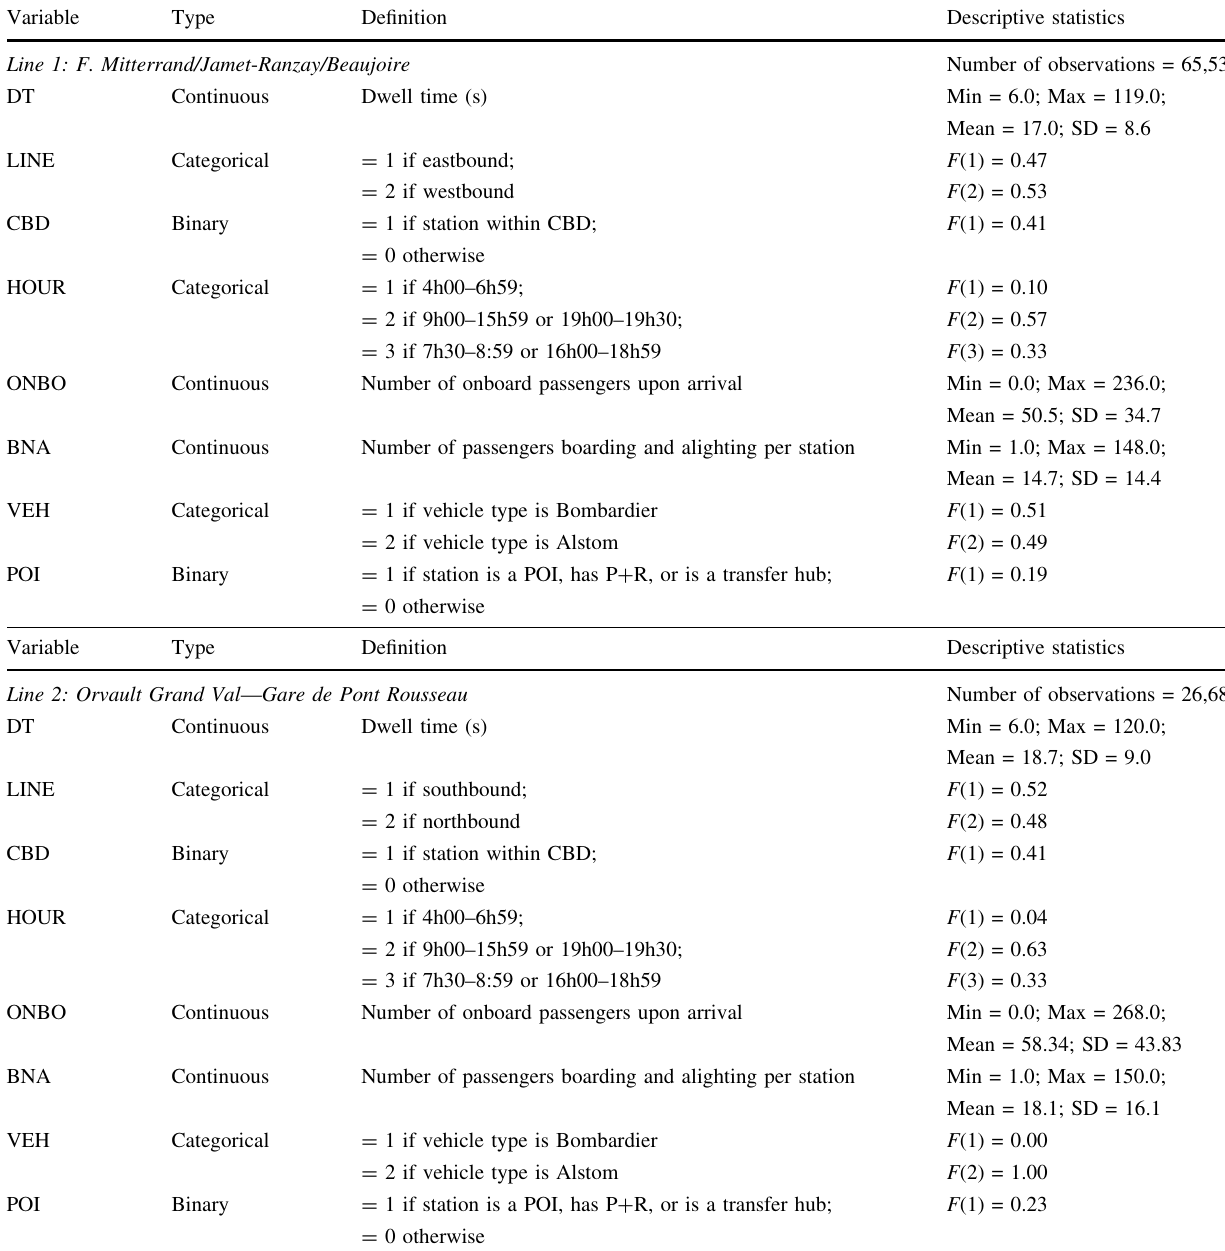
Table 1 Descriptive statistics of the dwell time regression